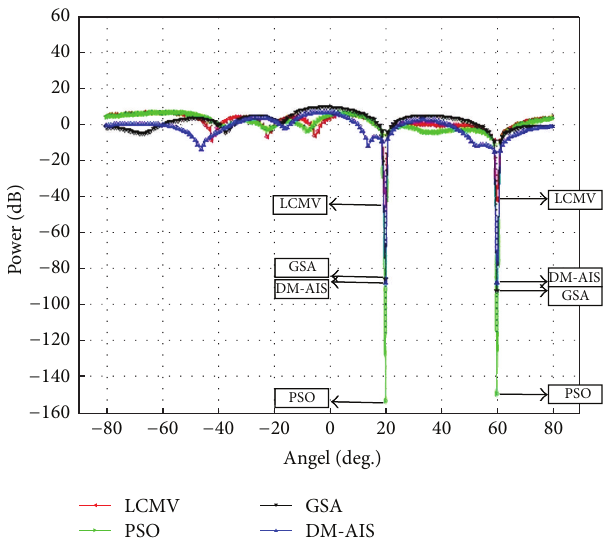
Figure 4: Comparison of performance of power response LCMV, PSO-LCMV, DM-AIS-LCMV, and GSA-LCMV for user at 0 ∘ with interference at 20 ∘ , 60 ∘ by using 8